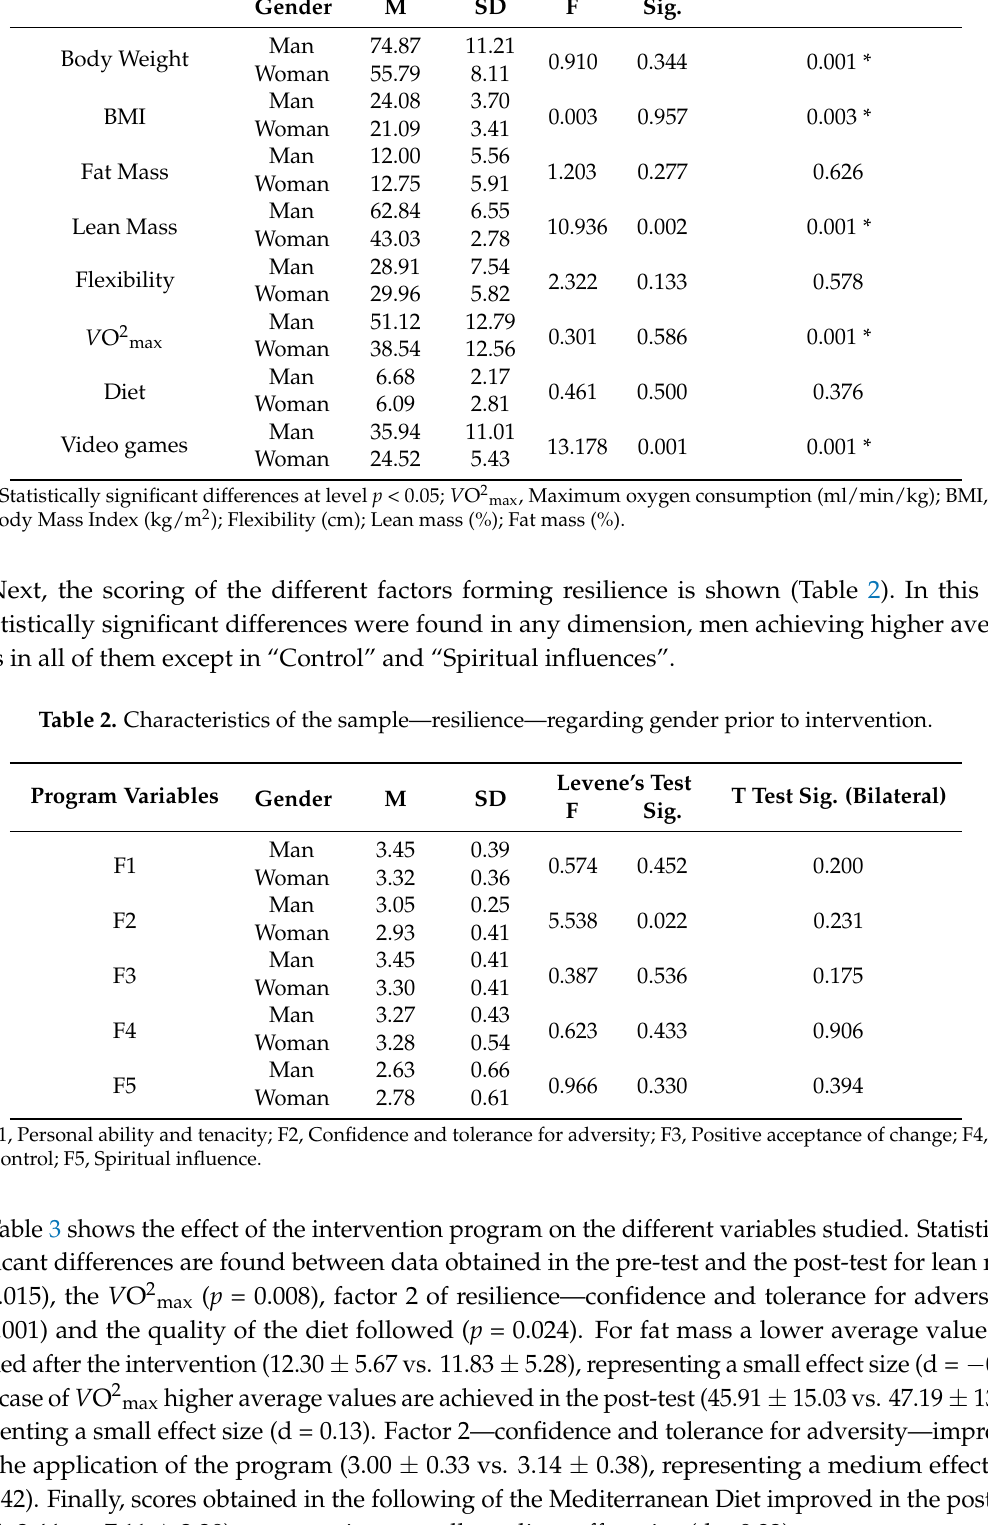
Levene’s Test T Test Sig. (Bilateral) 0.910